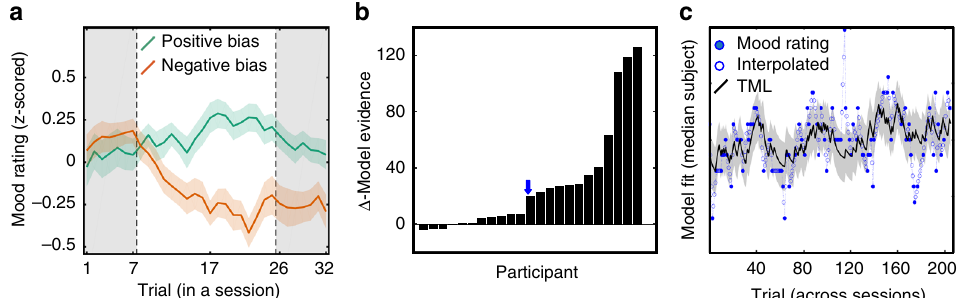
Fig. 4 Mood fl uctuations. a Variations in mood rating during sessions with positive (green) vs. negative (red) bias, across trials. Bias here means more or less dif fi cult questions, and more or less correct feedback. Note that the seven fi rst and seven last questions of a session (grey windows) were not biased (dif fi culty was medium). Lines represent means; error bars represent inter-subject s.e.m. The other panels show how well the computational model captured fl uctuations in mood level. b Individual differences in model evidence (variational Bayesian approximation to marginal likelihood) between the best mood model and the control model (in which only time was taken into account). Participants were ranked from left to right in ascending order of model evidence. Blue arrow indicates the subject with median model evidence, plotted in the next panel. c Individual example of mood fl uctuations across trials. Blue circles are mood ratings (measured or interpolated) and black line is theoretical mood level (TML). See Supplementary Fig. 1 for other individual